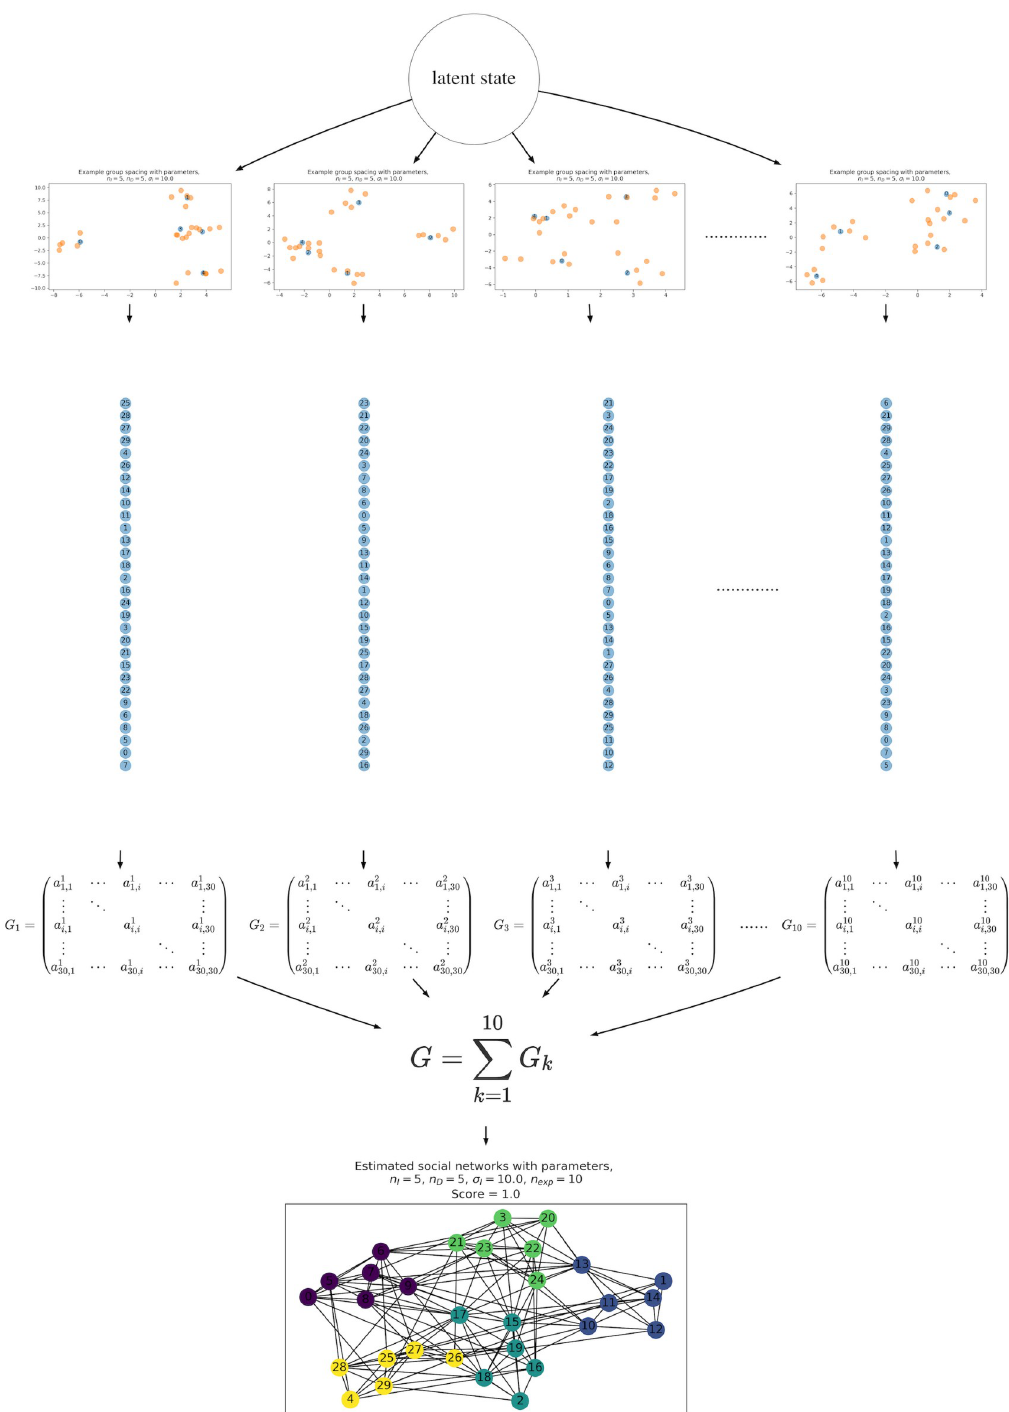
Fig 3. Example of a social network graph clustered using the Louvain algorithm. This graph was generated from the spacing patterns of animal agents shown in Fig 2.